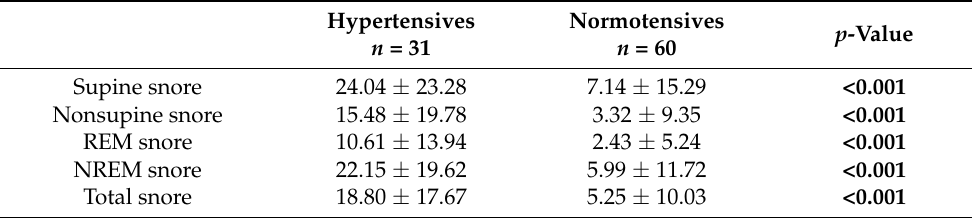
Table 5. Snoring parameters (% TST) determined in the study group and control group. Hypertensives Normotensives p -Value n = 31 n = 60 Supine snore 24.04 ± 23.28 7.14 ± 15.29 <0.001 Nonsupine snore 15.48 ± 19.78 3.32 ± 9.35 <0.001 REM snore 10.61 ± 13.94 2.43 ± 5.24 <0.001 NREM snore 22.15 ± 19.62 5.99 ± 11.72 <0.001 Total snore 18.80 ± 17.67 5.25 ± 10.03